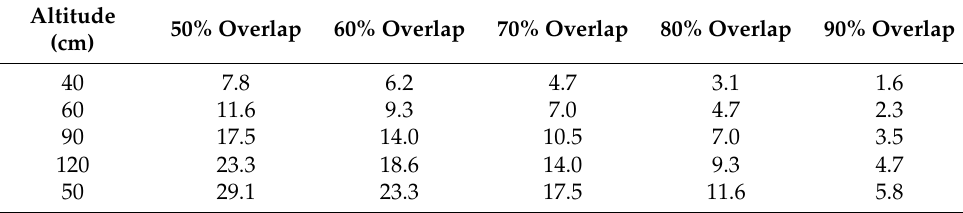
Table 4. Altitude and suggested speed for sensors